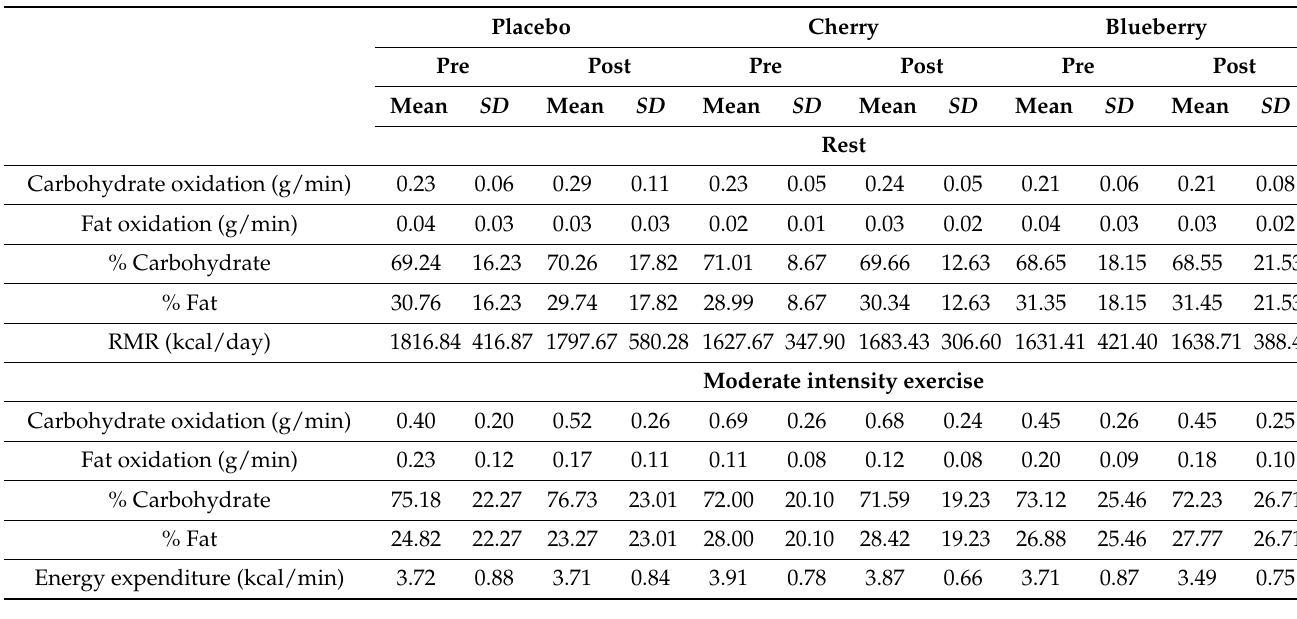
Table 4. Energy expenditure and substrate oxidation measurements as a function of each trial arm. Placebo